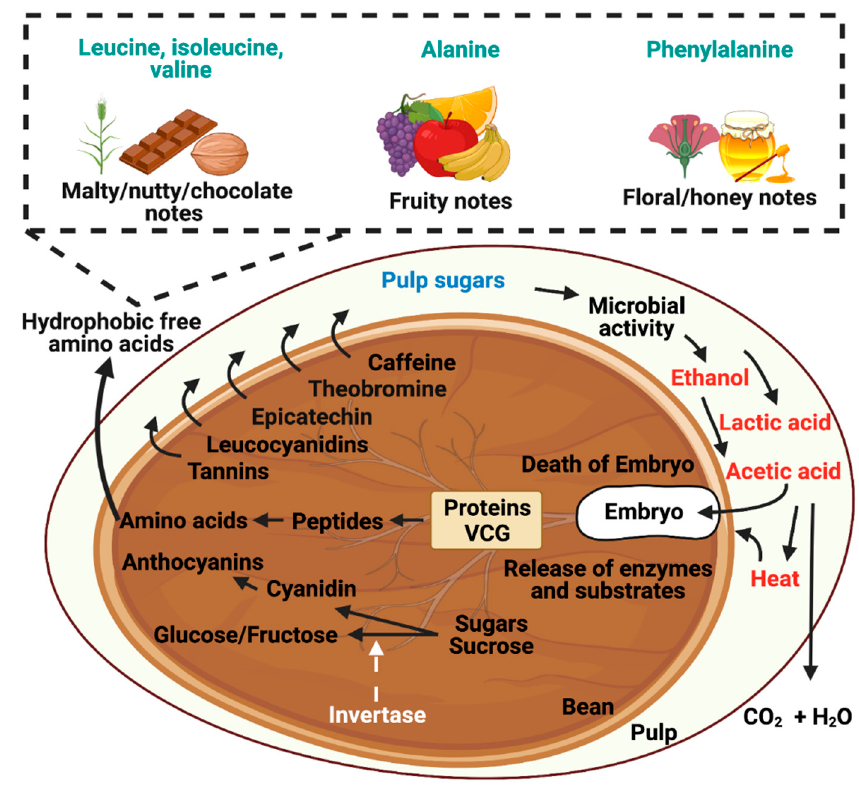
Figure 3. Formation of flavor precursors from hydrophobic-free amino acids. Microorganisms utilize the available substrates present in the cocoa pulp, such as carbohydrates, pectin, and organic acids, to produce the main metabolites of the process, such as ethanol, lactic acid, and acetic acid. Acetic acid penetrates the beans’ interior, causing the embryo’s death and the release of enzymes and endogenous substrates that, through proteolytic reactions, generate the flavor precursors (amino acids).